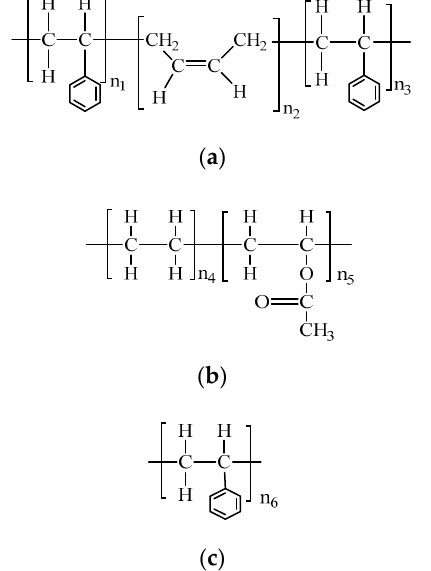
Figure 2. The chemical formulas for the active component in additive: ( a ) Styrene–Butadiene-Styrene (SBS) polymers; ( b ) ethylene-vinyl acetate copolymer; ( c ) polystyrene.